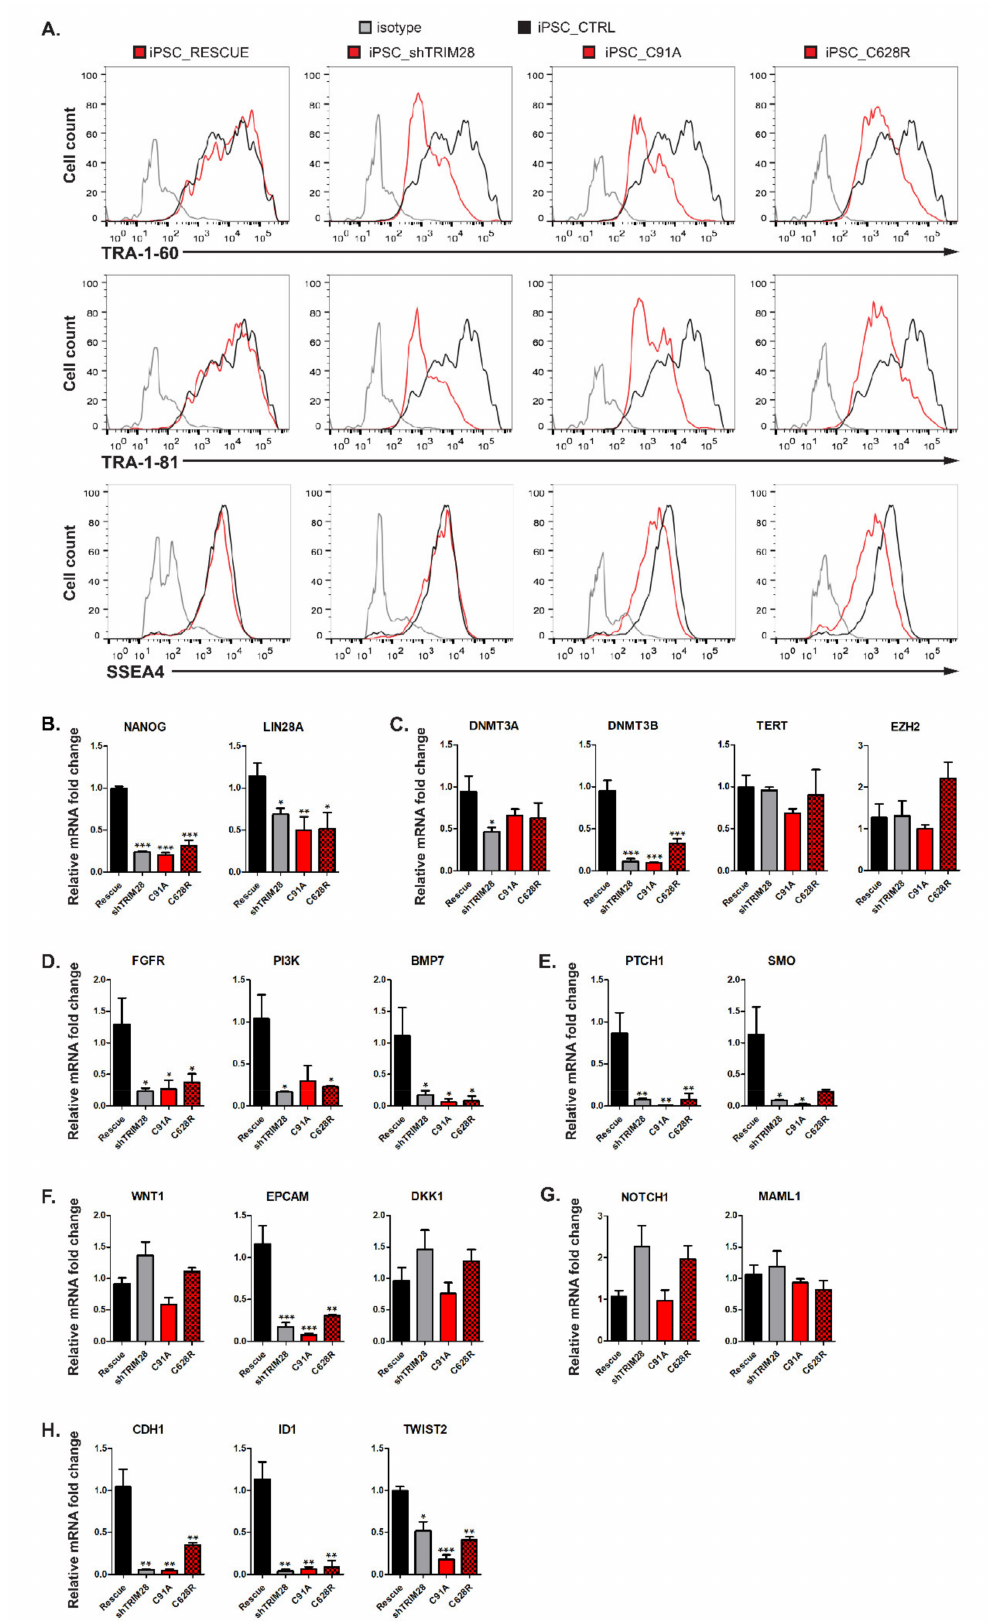
Figure 6. Impairment of RING and PHD functions results in dysregulation of stem cell-associated signaling